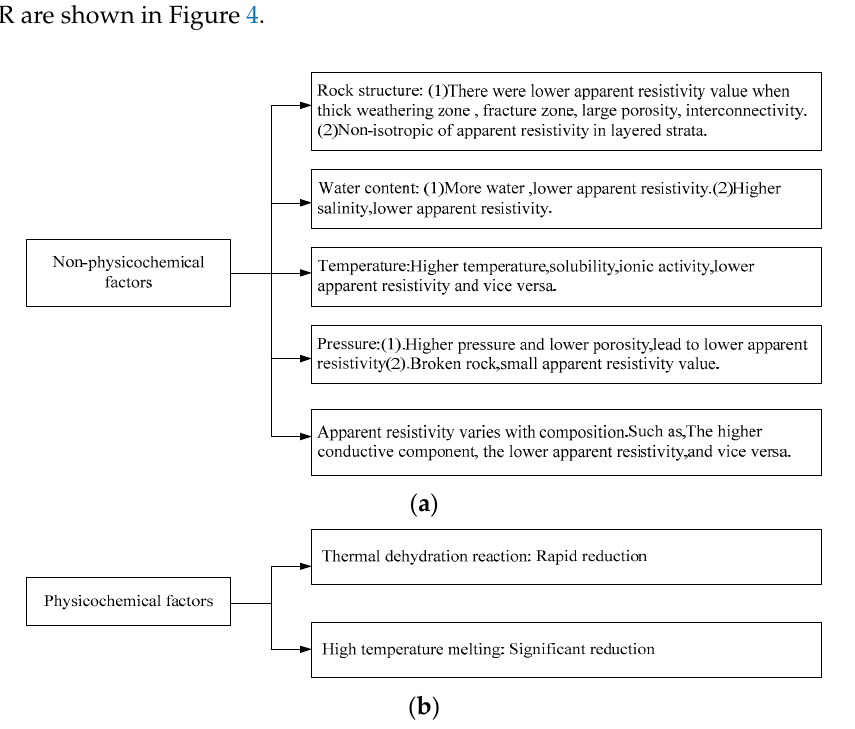
Figure 4. The main influencing factors of AR: ( a ) non-physicochemical factors; ( b ) physicochemical factors.